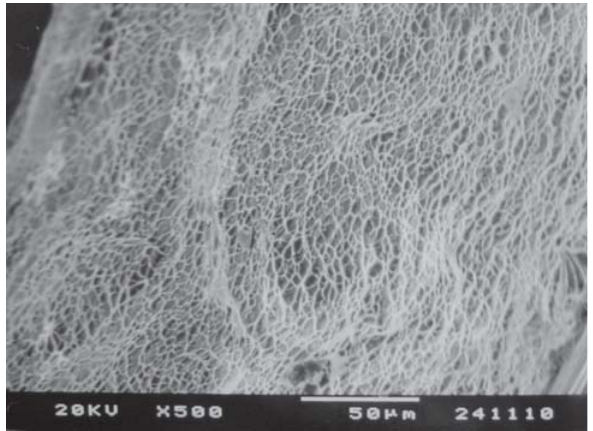
FIGURE 4- Mixed fracture with predominance of fragile fracture F(+) 500x